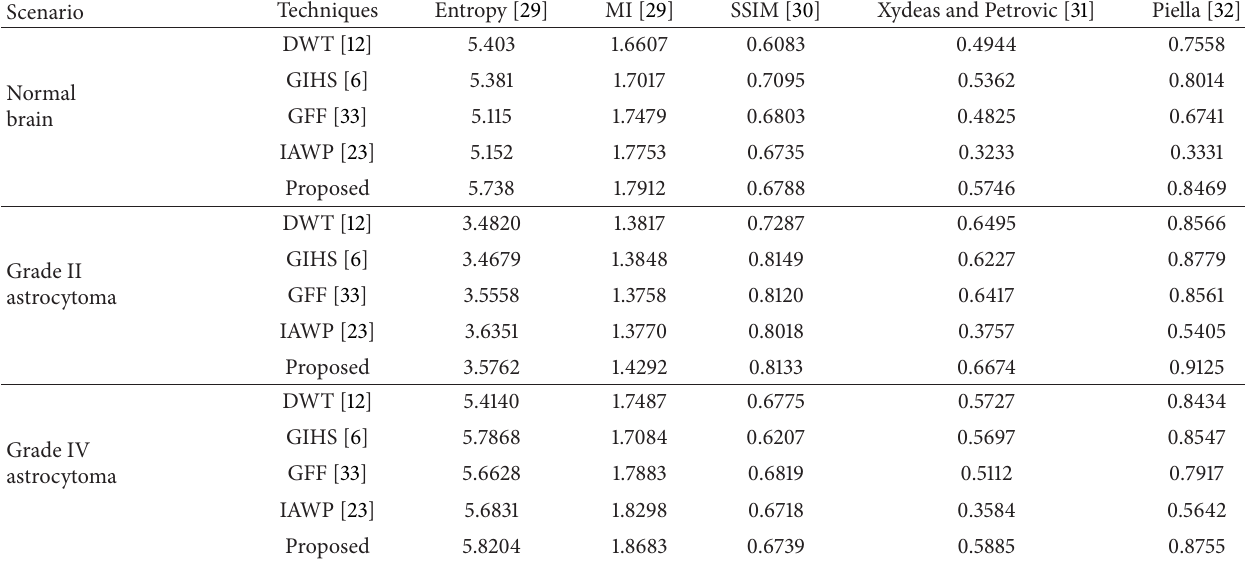
Table 1: Quantitative measures for fused PET-MRI